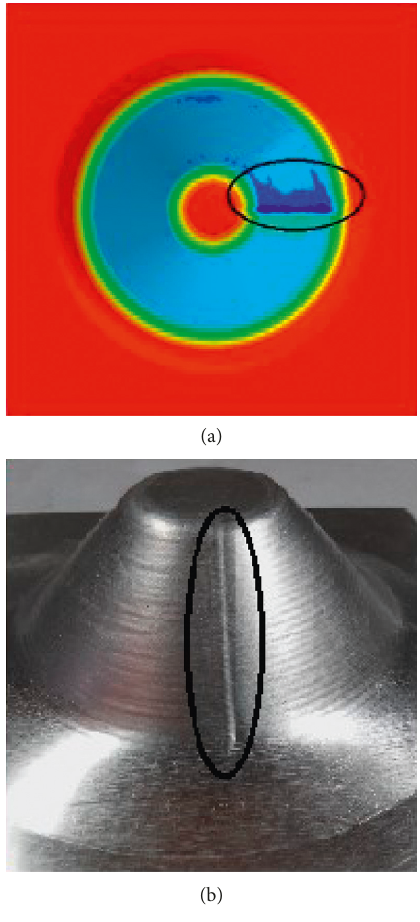
Figure 12: Effect of a single forming trajectory.